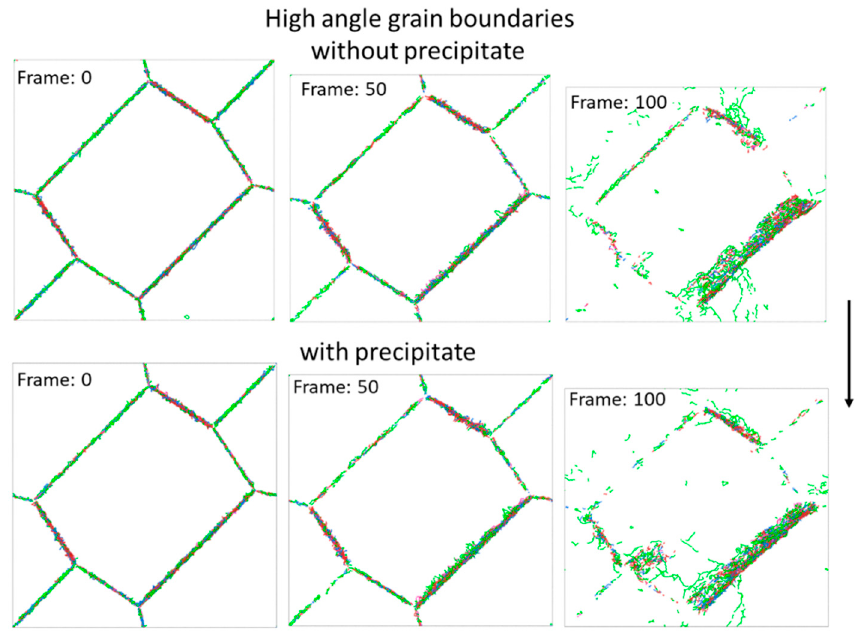
Figure 10. Evolution of defects during compression of grains with HABs (arrow indicates compression direction).